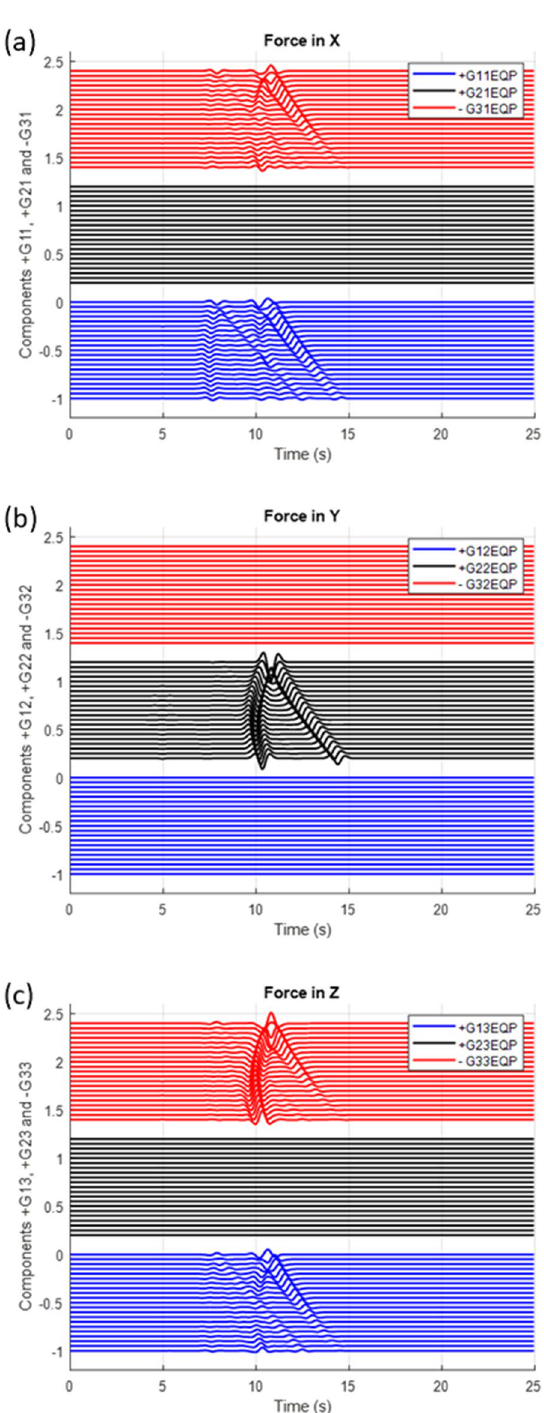
Fig. 8 The three panels depict the Green’s function convolved with a Ricker pulse with t p 1 s and t s 5 s. The three forces (sources) are = = located at depth of z 3 km and x y 0 and the receivers are 21 = = = and are located at x 5 km, y 0 and depths equally distributed from = = z 0 and 5 km, plotted in descending order from the free surface. The = sign of vertical components (in red) has been changed. The ordinates’ unit is meters after the common factor 2 π 10 4 R − 1 0 is